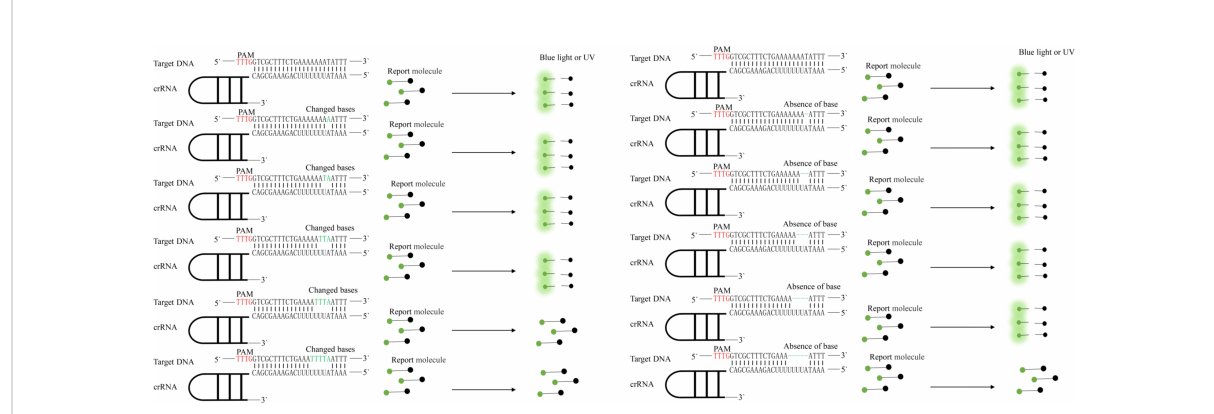
FIGURE 3 Speci fi city of the CRISPR-Cas12a enhanced fl uorescent assay evaluated by its ability to distinguish base mismatches. Protospacer adjacent motif (PAM) sequences are shown in red; base mismatches are shown in green.